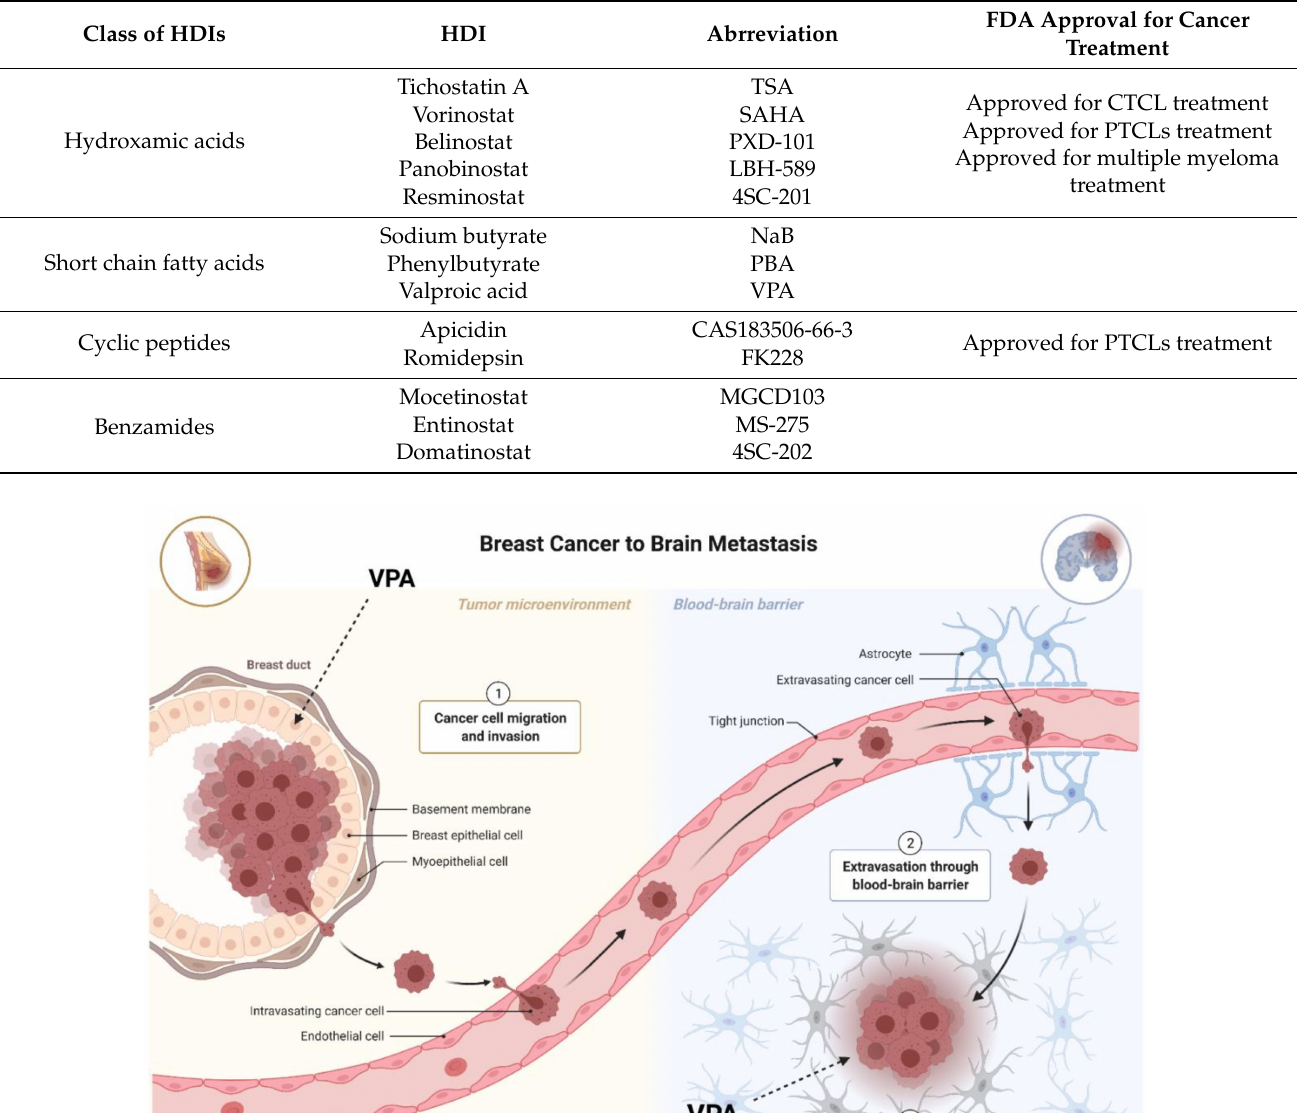
Table 2. Classes of histone deacetylase inhibitors (HDIs) (CTCL-cutaneous T-cell lymphoma, FDA-Food and Drug Adminis- tration, PTCL-peripheral T-cell lymphoma) [10].